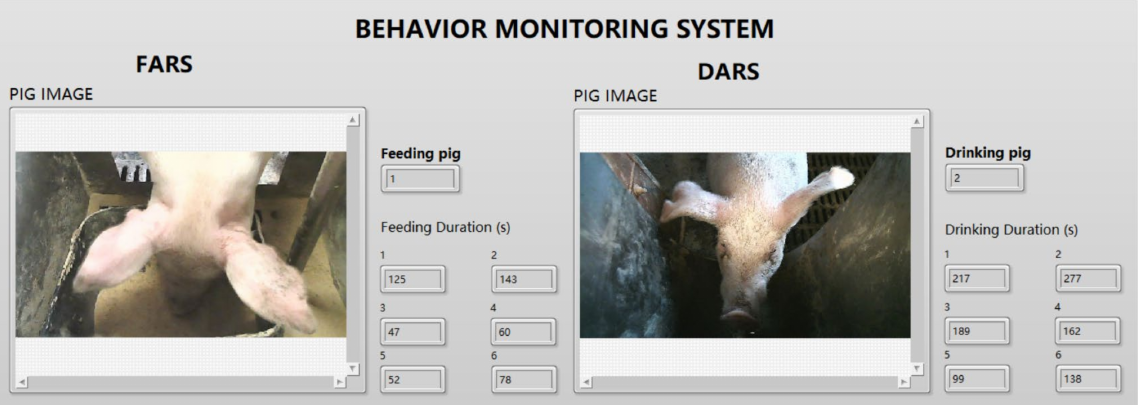
Figure 11. Front panel of the behavior monitoring